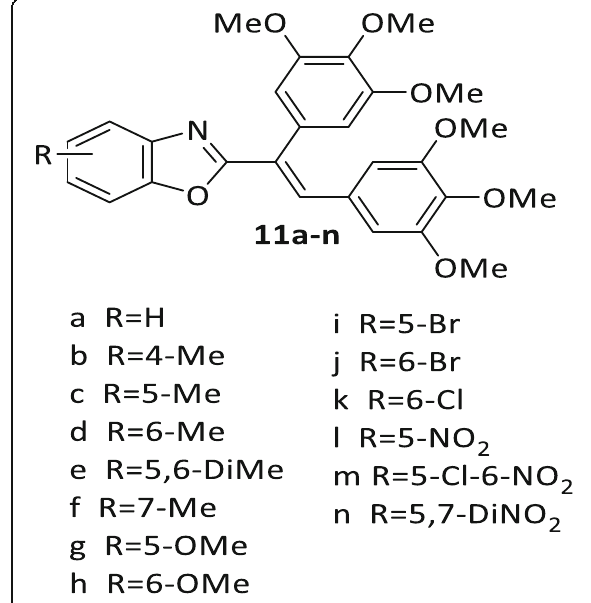
Fig. 11 Benzoxazole-combretastatin